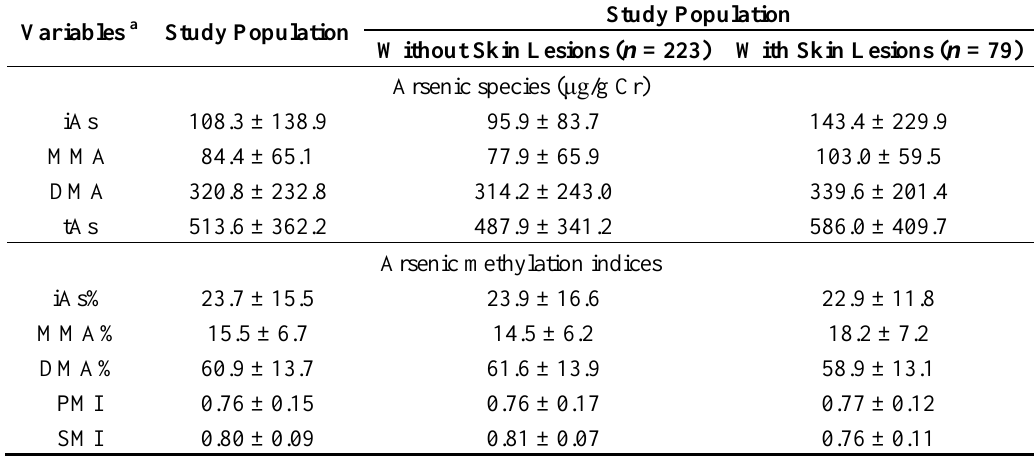
Table 1. Urinary arsenic species and methylation indices of the study population ( n = 302). Variables